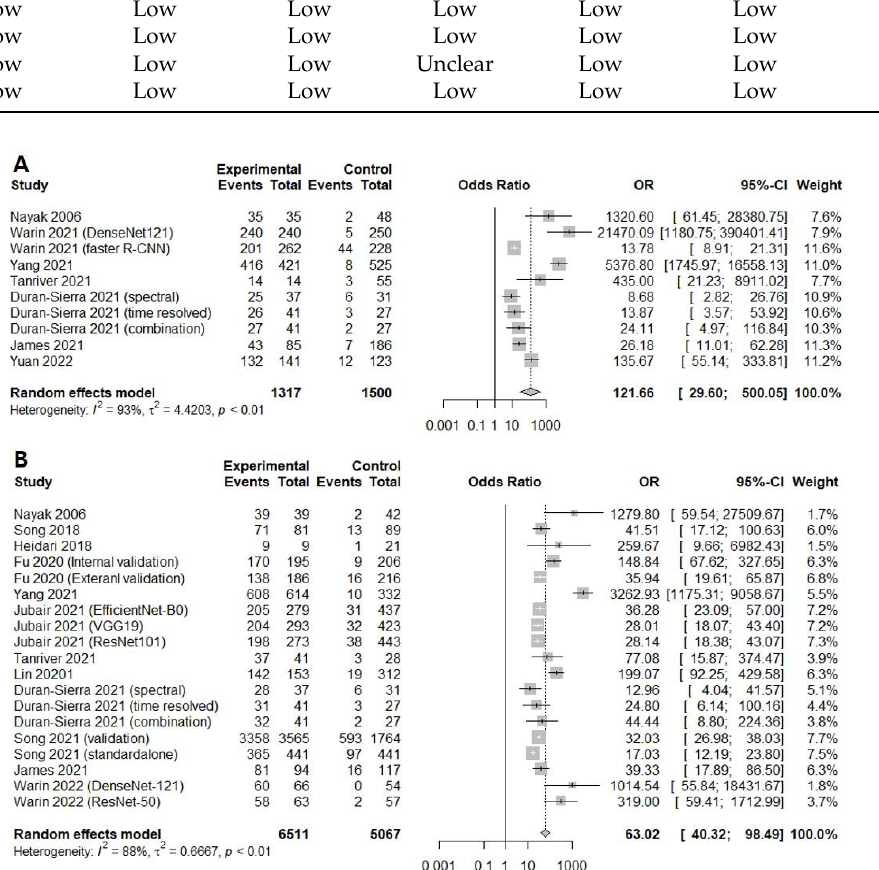
Figure 2. Forest plot of the diagnostic odds ratios for ( A ) screening only oral cancerous lesions